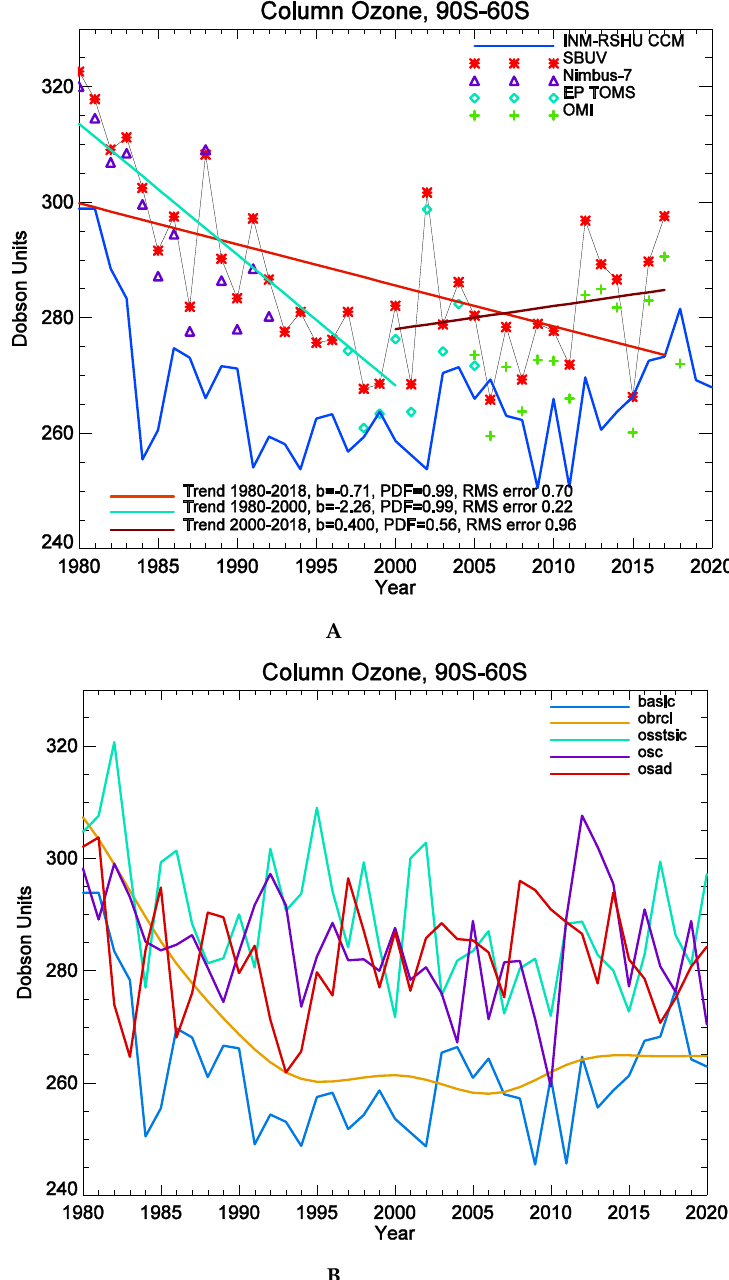
Figure 6. Interannual variability of column ozone in the southern polar latitudes: ( A ) Results of satellite measurements (solar backscattering ultraviolet (SBUV), Nimbus-7 Total Ozone Mapping Spectrometer (TOMS), Earth Probe (EP) TOMS, and the Ozone Monitoring Instrument (OMI)) and numerical modeling (chemistry–climate model of the Institute of Numerical Mathematics and the Russian State Hydrometeorological University) with an assessment of trends (b—coefficient of linear regression) and their significance (PDF—probability density function, and RMS—root mean square error); ( B ) results of numerical modeling under scenarios with a separate action of influencing factors: basic—all factors’ interannual variabilities are taken into account, obrcl—only the surface emissions of bromine and chlorine-containing gases’ interannual variability is taken into account, osstsic—only sea surface temperature and sea ice coverage interannual variabilities are taken into account, osc—only solar radiation’s interannual variability is taken into account, osad—only sulfate aerosol density’s interannual variability is taken into account.